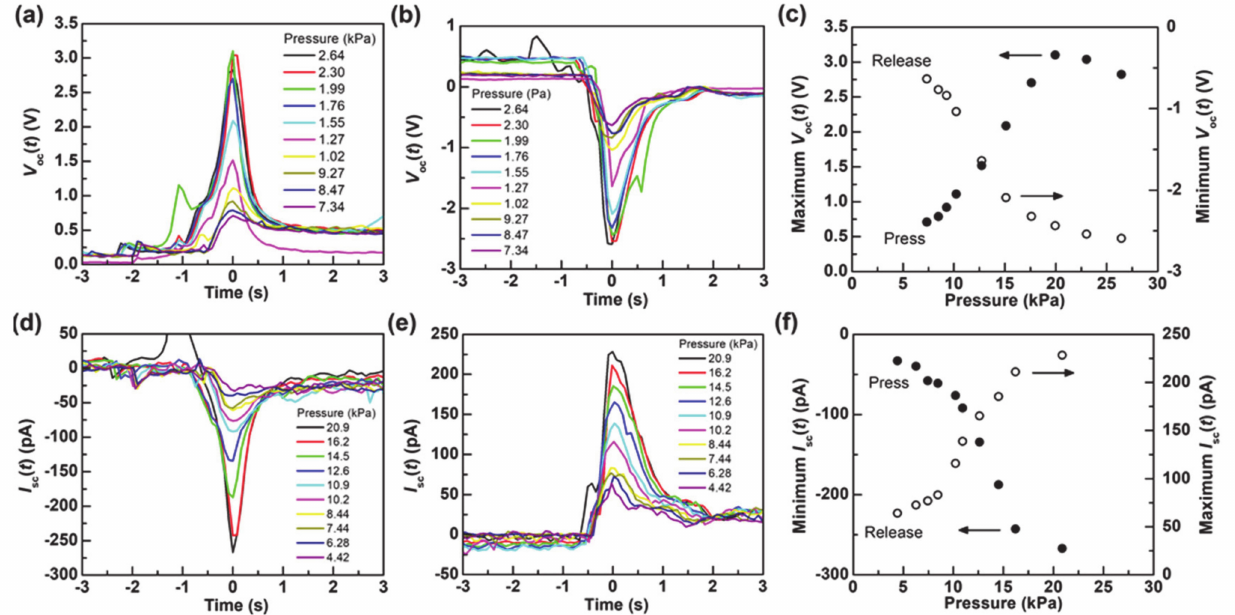
Figure 5. ( a , b ) V oc ( t ) when the sensor was ( a ) loaded and ( b ) released. ( c ) The maximum/minimum V oc ( t ) with different applied pressures. ( d , e ) I sc ( t ) when the sensor was ( d ) loaded and ( e ) released. ( f ) The maximum/minimum I sc ( t ) with different applied